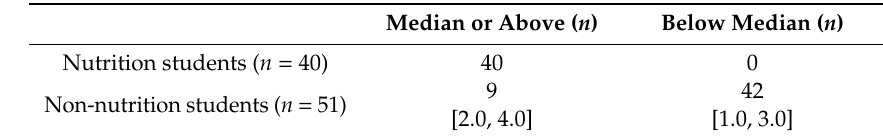
Table 2. Median-split table for nutrition and non-nutrition students’ total nutrition knowledge scores ( n =